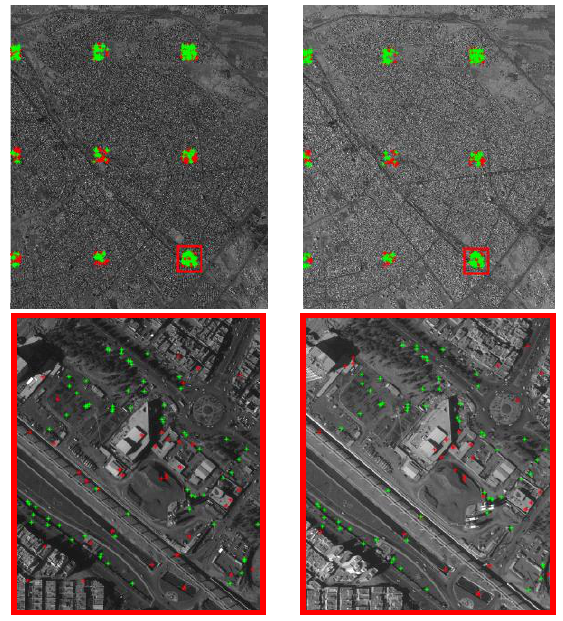
Figure 6. Key features extracted in 9 Gruber areas for corresponding original images After co-registration of images, left image is divided into 3000*3000 tiles and their corresponding areas are found using